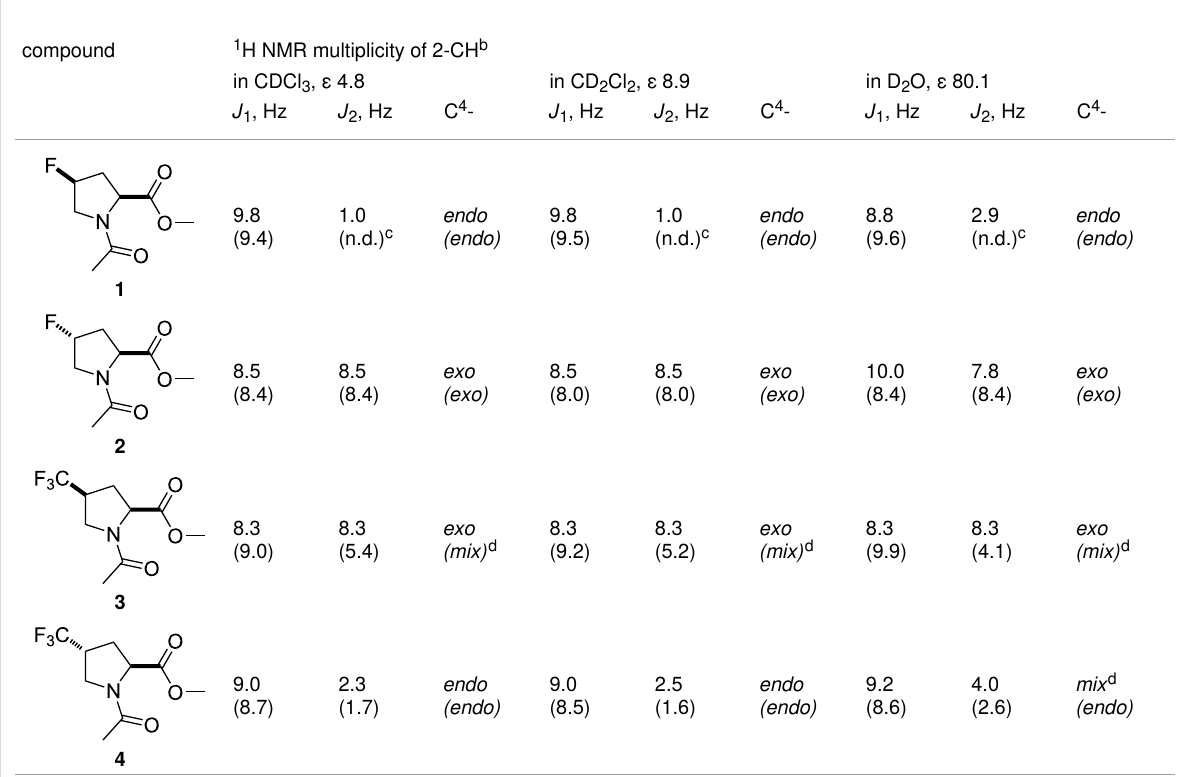
Table 1: 2-CH multiplicity data and the conclusions regarding the C 4 conformation in the model compounds. a